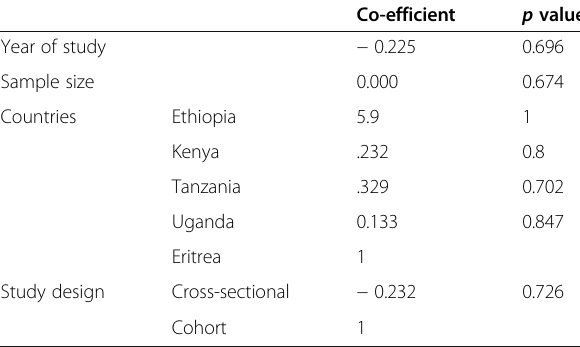
Table 2 Univariate meta-regression analysis for vertical HIV infection in East Africa, 2019